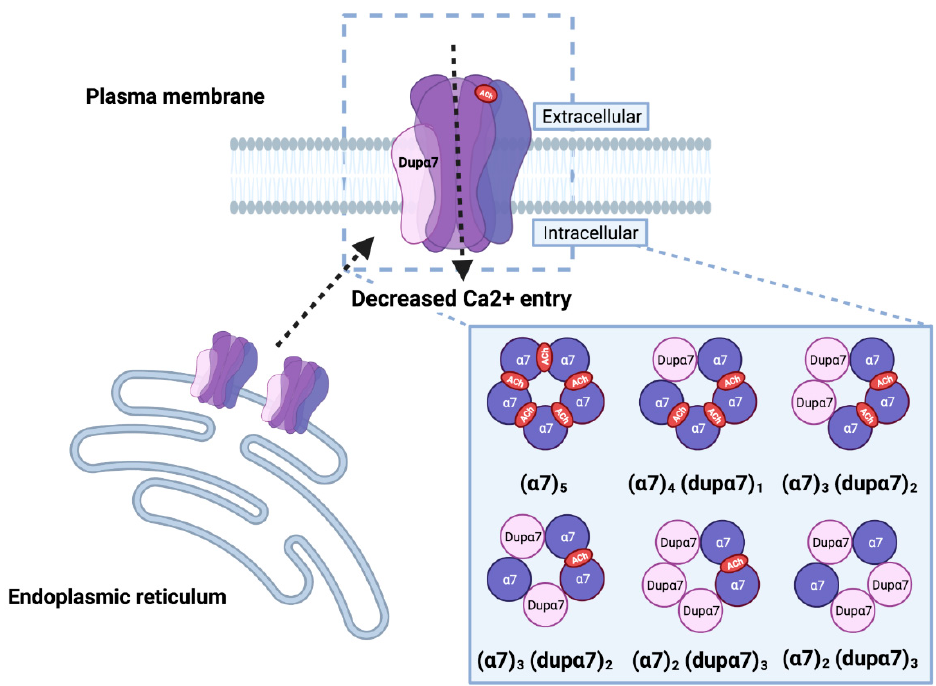
Figure 4. The heteromeric α 7/dup α 7 receptor. Dup α 7 can assemble and interact with α 7 subunits to form heteropentameric receptors, causing reduced function of the receptor at the cell membrane (dashed line), as demonstrated by a net reduction in the macroscopic current, that is inversely proportional to the amount of dup α 7 and/or retention (dashed line) at the endoplasmic reticulum (ER). In order for the heteromeric receptor to be functional, it should include at least two α 7 subunits to form the agonist binding site. The possible stoichiometries of the heteromeric receptor are the result of experimental data and computational model simulations. (Created with BioRender.com (accessed on 12 March 2022)).